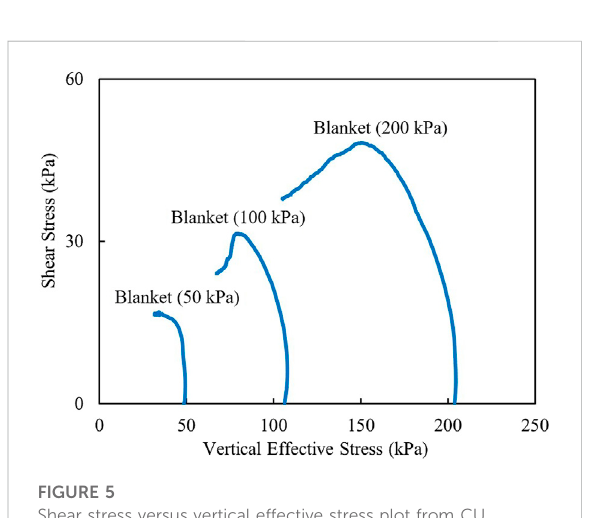
FIGURE 7 Porewater pressure measurements from CU direct simple shear tests on CB clay blanket